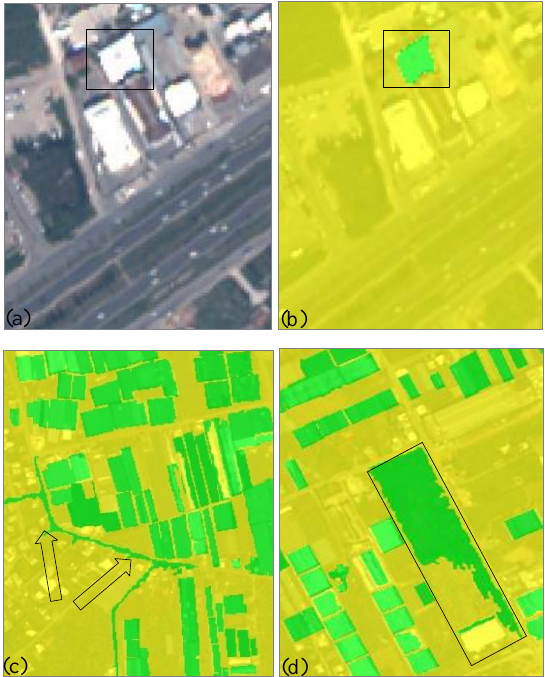
Figure 7. (a) White building. (b) Inaccurately classified white building. (c) Inaccurately classified road. (d) Inaccurately classified bare